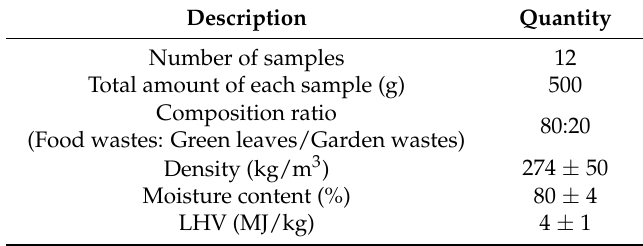
LHV: lower heating